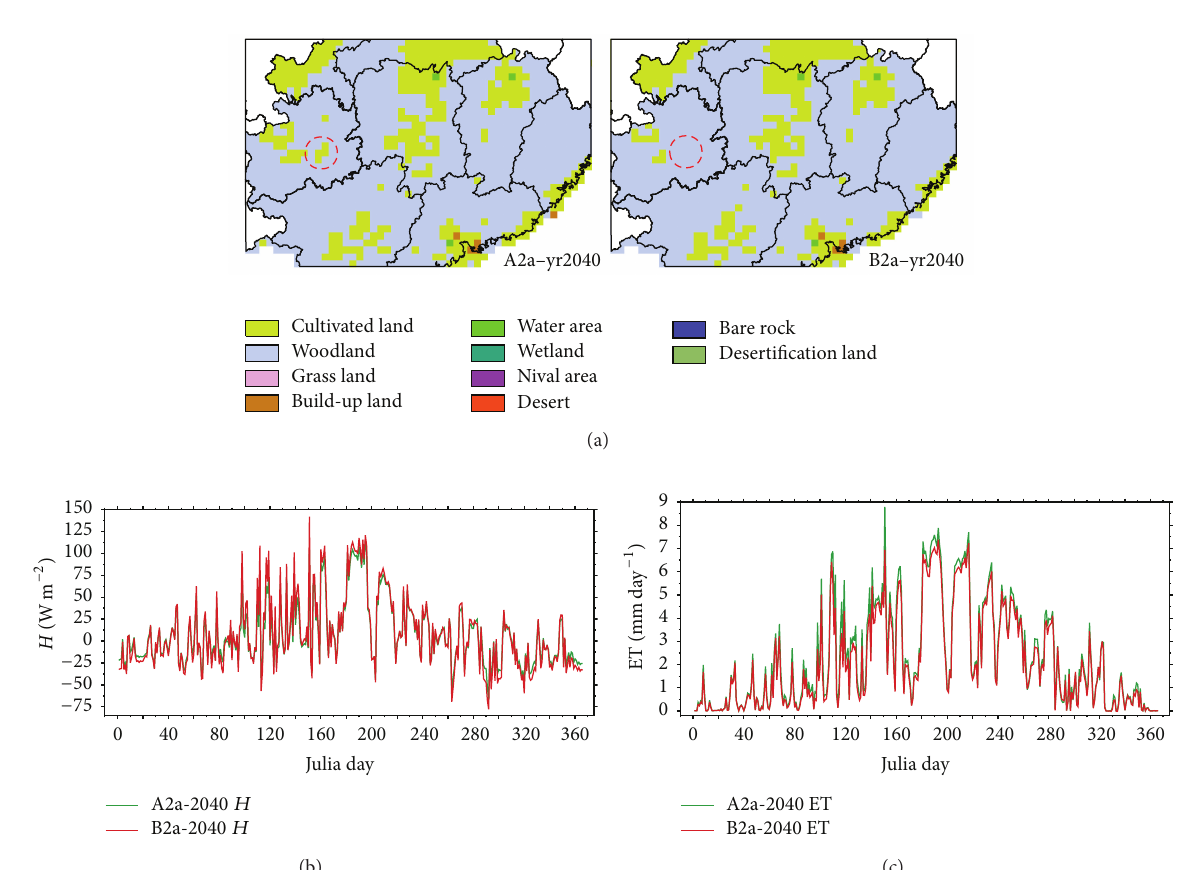
Figure 9: Analysis of the impact of land cover scenario process on water and heat exchange for the year 2040 located in the east of Guizhou